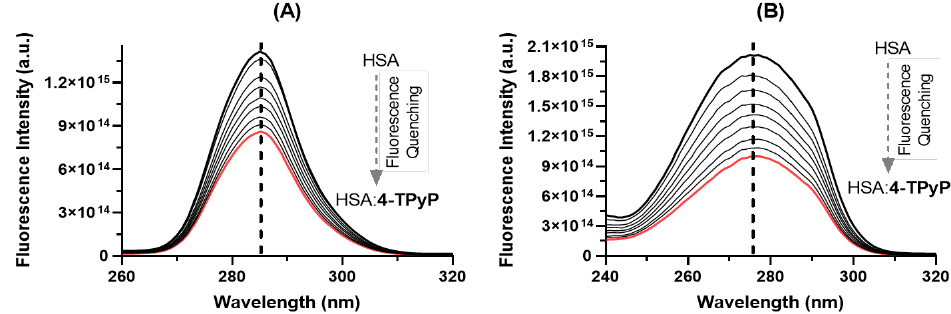
Figure 4. The SF spectra of HSA without and upon successive additions of 4-TPyP at ( A ) Δλ = 15 nm and ( B ) Δλ = 60 nm in pH = 7.4 at room temperature. [HSA] = 1.0 × 10 −5 M and [4-TPyP] = 0.17, 0.33, 0.50, 0.66, 0.83, 0.99, 1.15, and 1.32 × 10 −5 M.